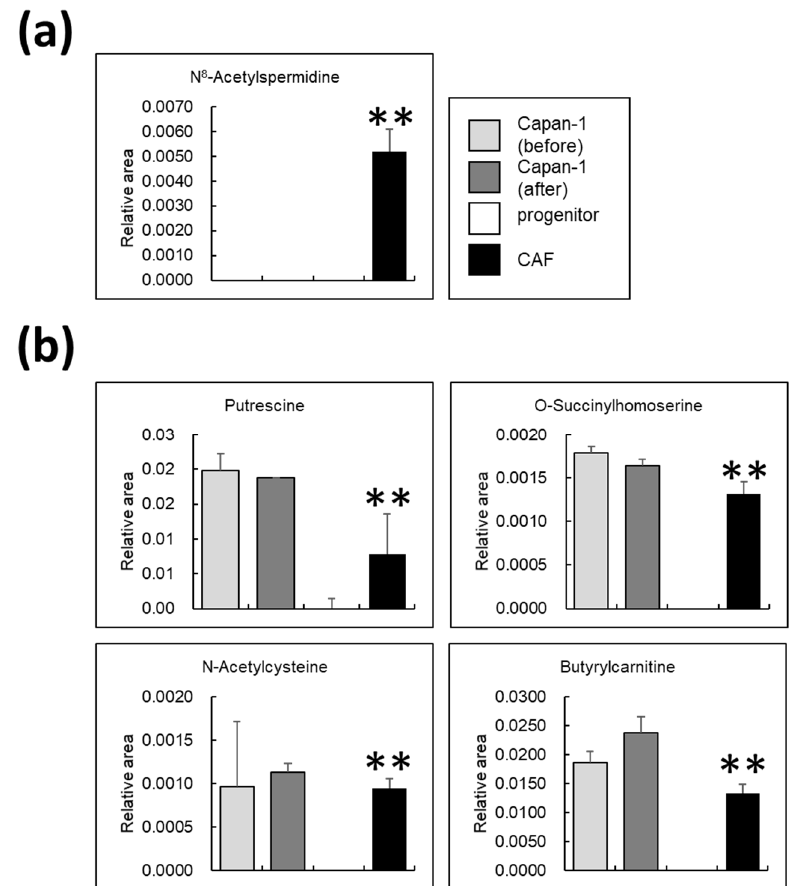
Figure 6. Metabolites specifically detected in cancer-associated fibroblasts (CAFs) alone and not CAF progenitors: ( a ) Amount of N8-acetylspermidine in all samples. N8-acetylspermidine was detected only in CAFs. ** p < 0.01; ( b ) Four metabolites detected solely in CAFs and not in the progenitors. ** p < 0.01.